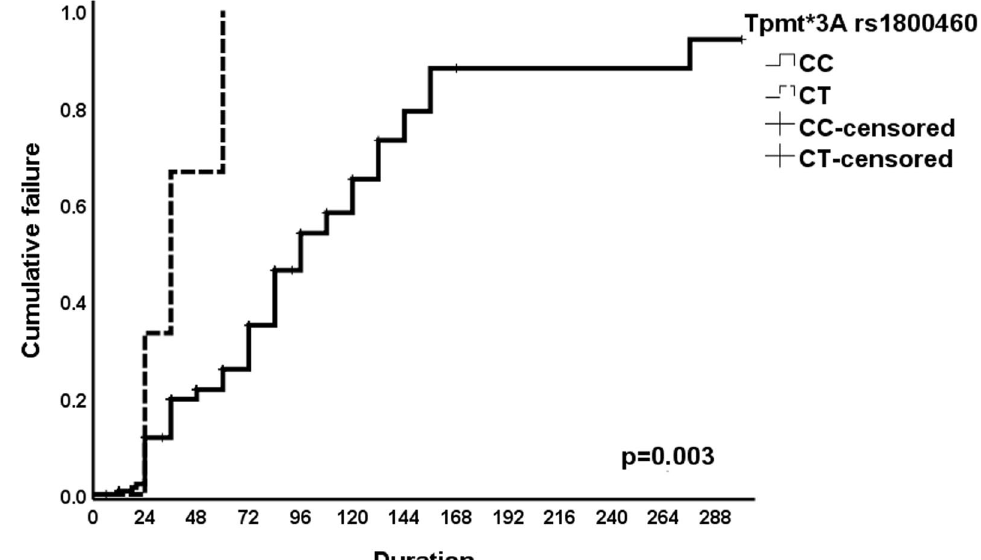
Fig. 5 Time to failure according to rs1800460